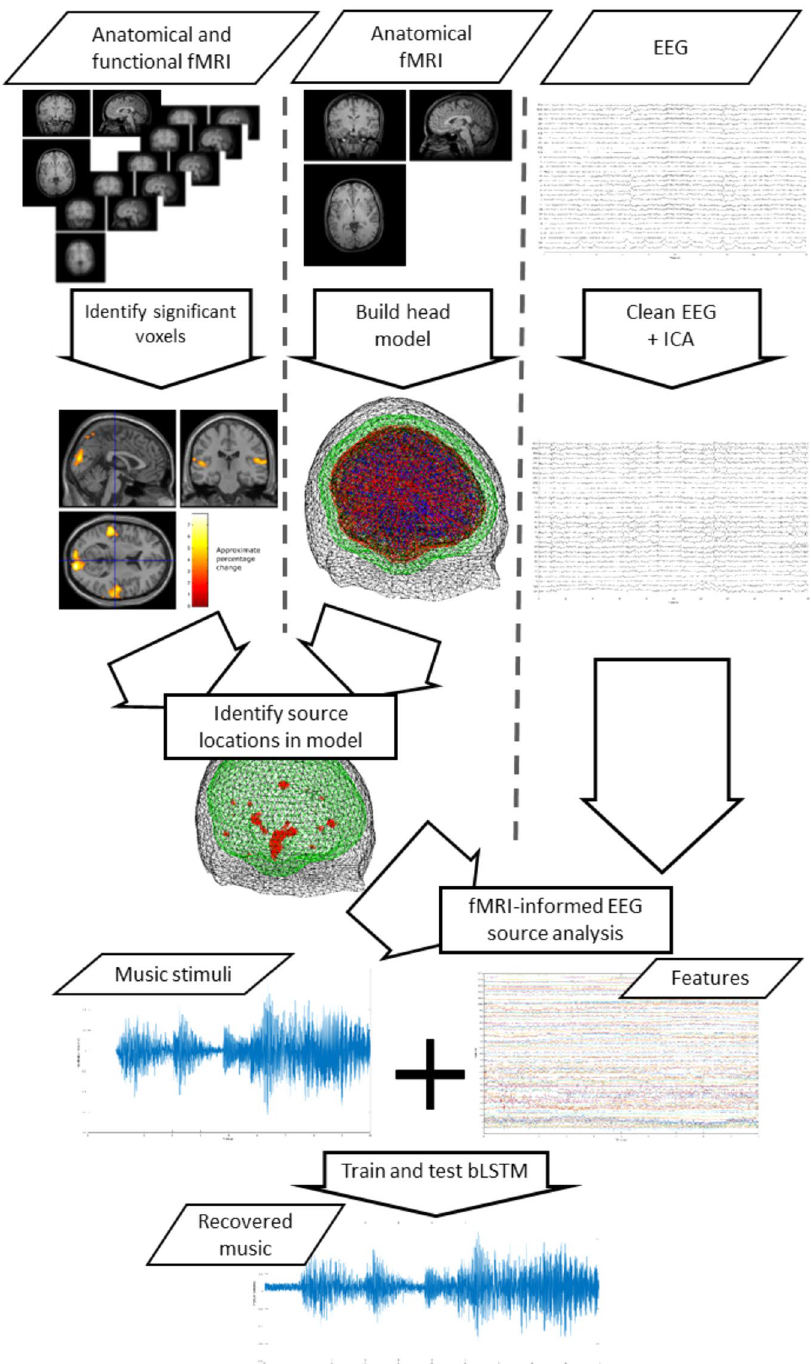
Figure 6. Analysis pipeline illustration. Anatomical MRI is used to construct head models, while fMRI is used to identify voxels that differ between music and no music conditions. EEG is decomposed via ICA and fMRI- informed source analysis is used to characterise activity at fMRI-identified locations. The resulting feature set is used to train a biLSTM to recover the music a participant listened to. A cross-fold train and validation scheme is used for each